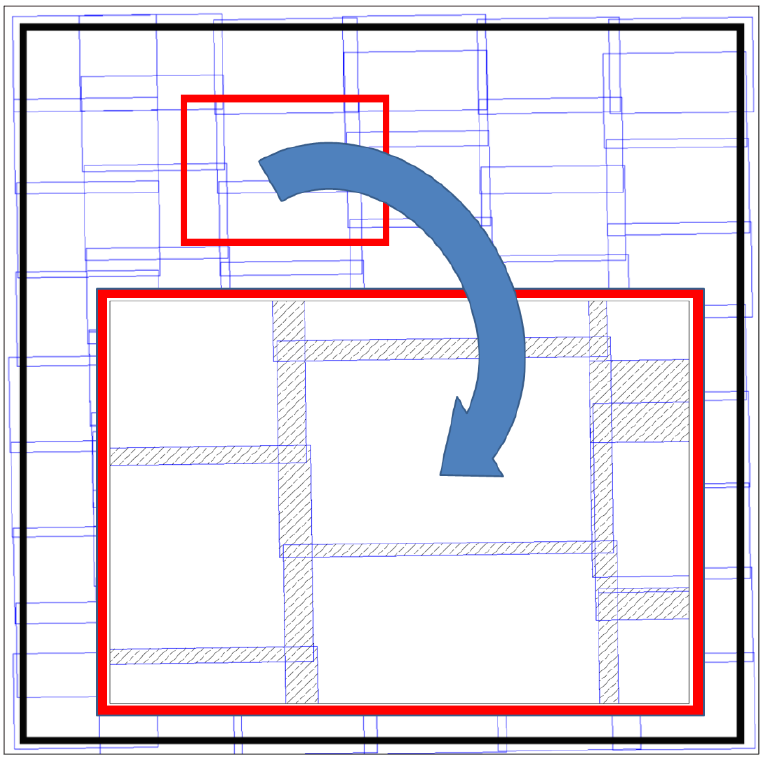
Figure 3. Overlapping borders of macro-photographic images covering a whole area of analysis. The black rectangle corresponds to the rectangular area of analysis marked on the polished surface.